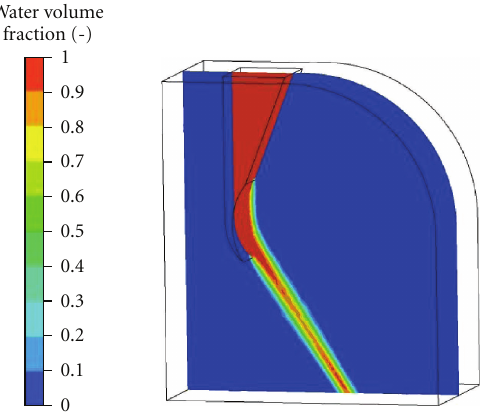
Figure 7: Water volume fraction contour at midspan of domain nozzle casing.